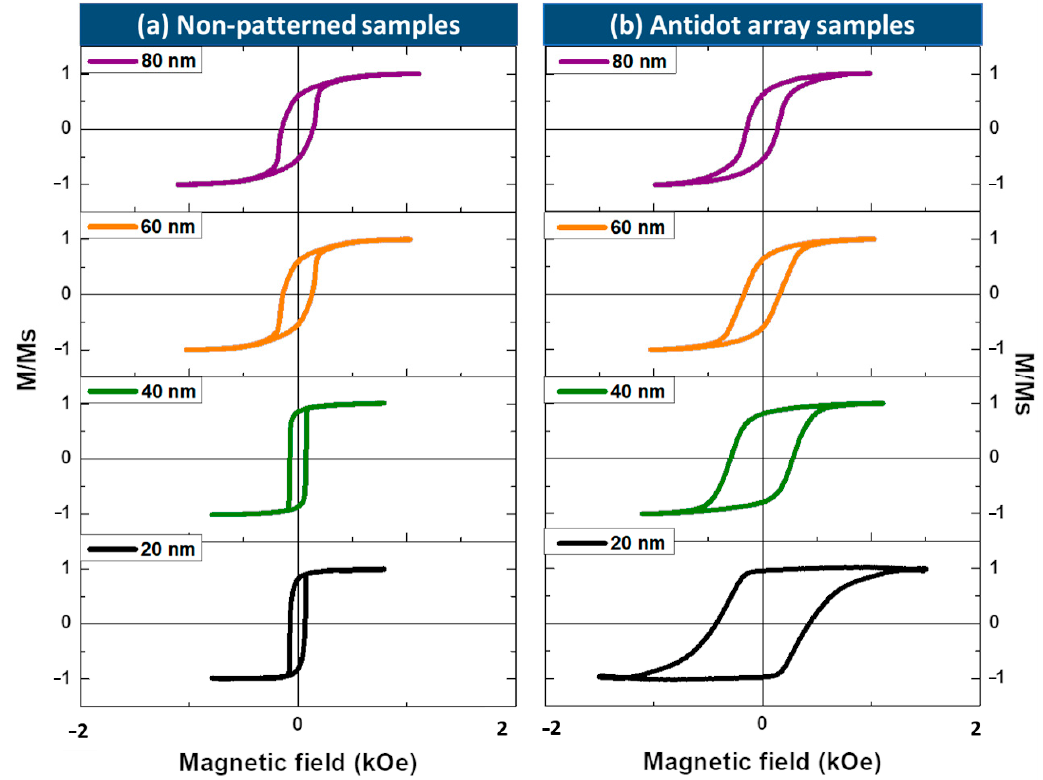
Figure 3. Transversal Kerr hysteresis loops for Fe 70 Pd 30 with different thicknesses (20, 40, 60 and 80 nm) for ( a ) non-patterned thin films and ( b ) antidot array thin films.